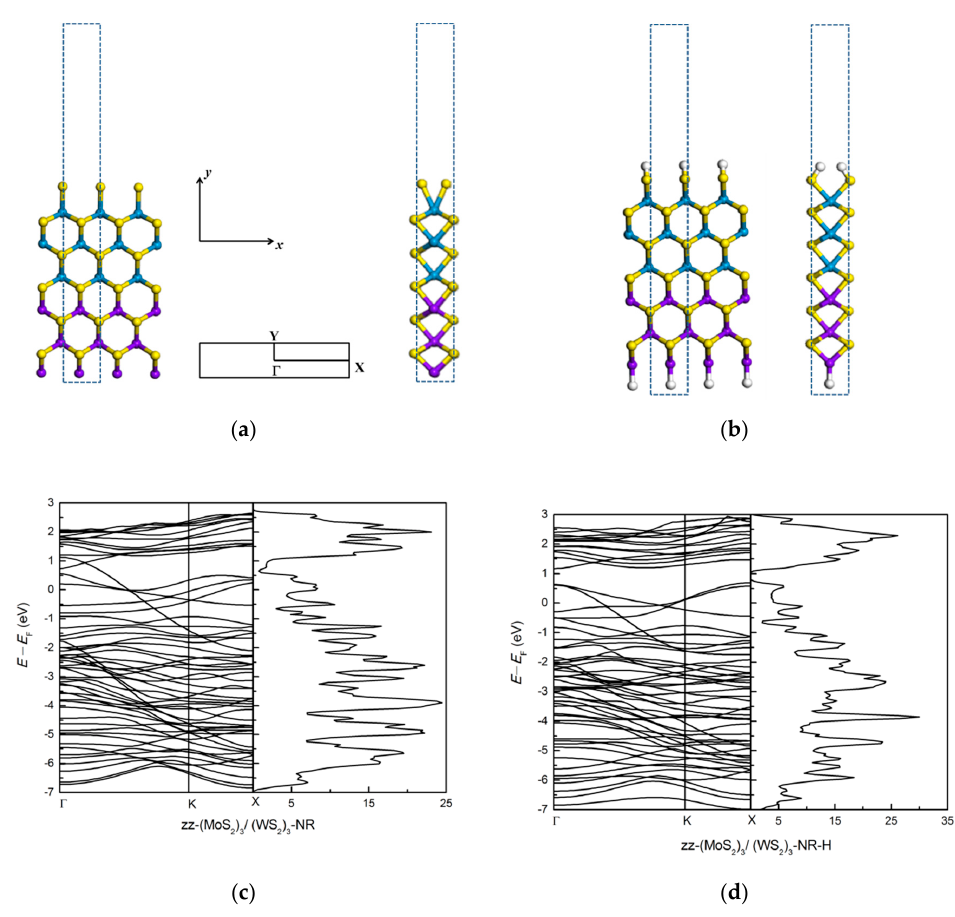
Figure 2. The atomic structure of zz-(MoS 2 ) 3 /(WS 2 ) 3 -NR and H-passivated of zz-(MoS 2 ) 3 /(WS 2 ) 3 -NR are shown in ( a , b ), respectively. The blue dotted rectangle shows the repeat unit cell in ( a ) and the high-symmetry points in Brillouin zone are marked. In panels ( c , d ) we show the electronic band structure and density of states (dos) of bare and H-passivated systems, respectively.